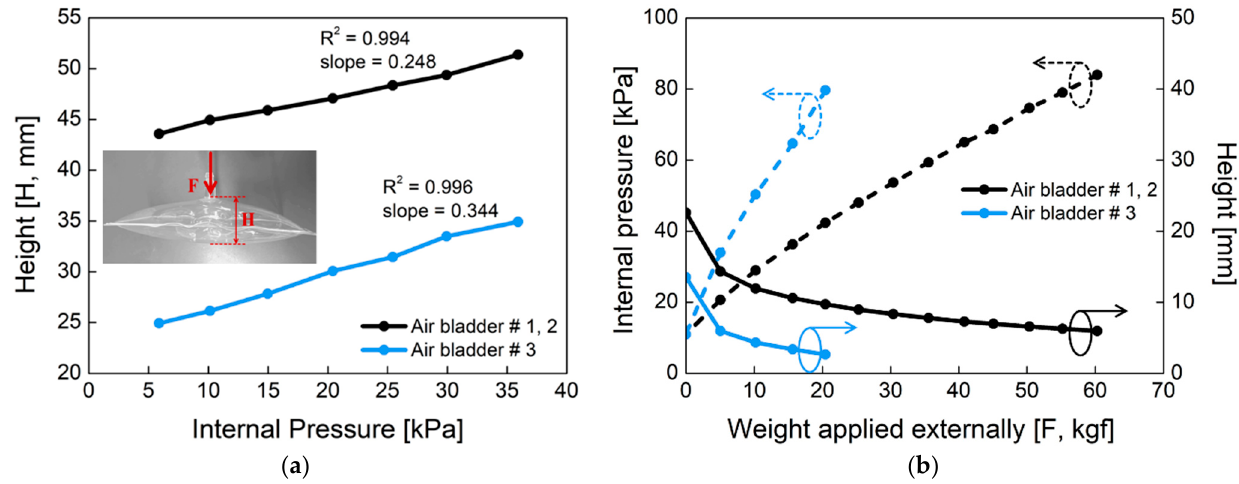
Figure 5. The mechanical properties of the air bladder. ( a ) Changes in the height of the air bladder according to the internal pressure; ( b ) changes in the internal pressure (dotted line) and height (full line) of the air bladder as the applied weight varies, when initial pressure in the air bladder is 11 kPa.